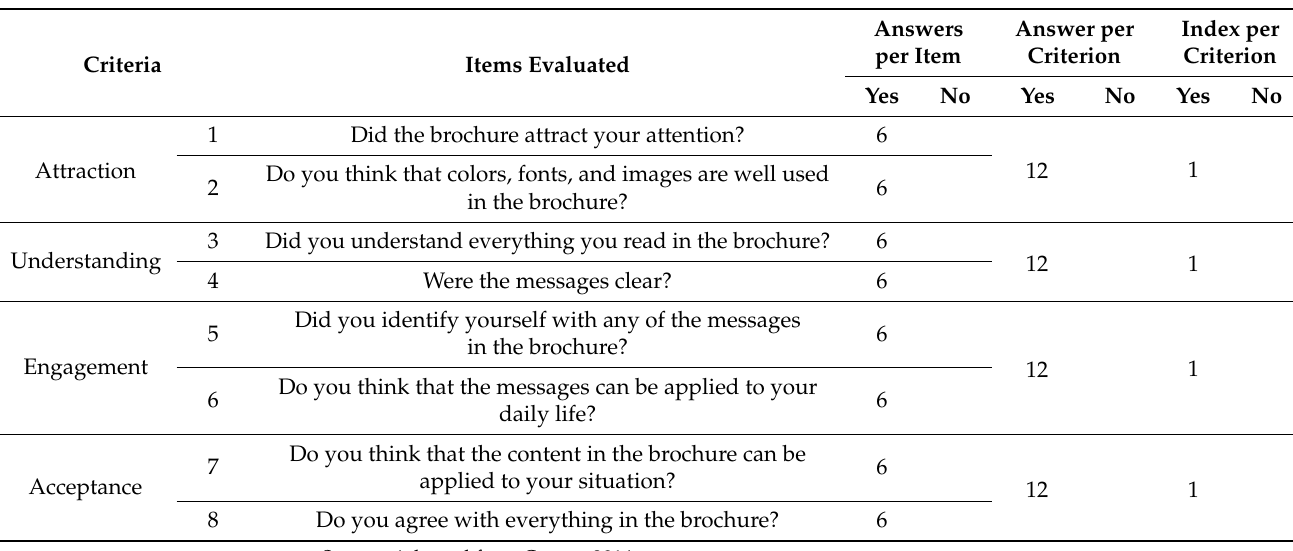
Table 1. Validity by patients.